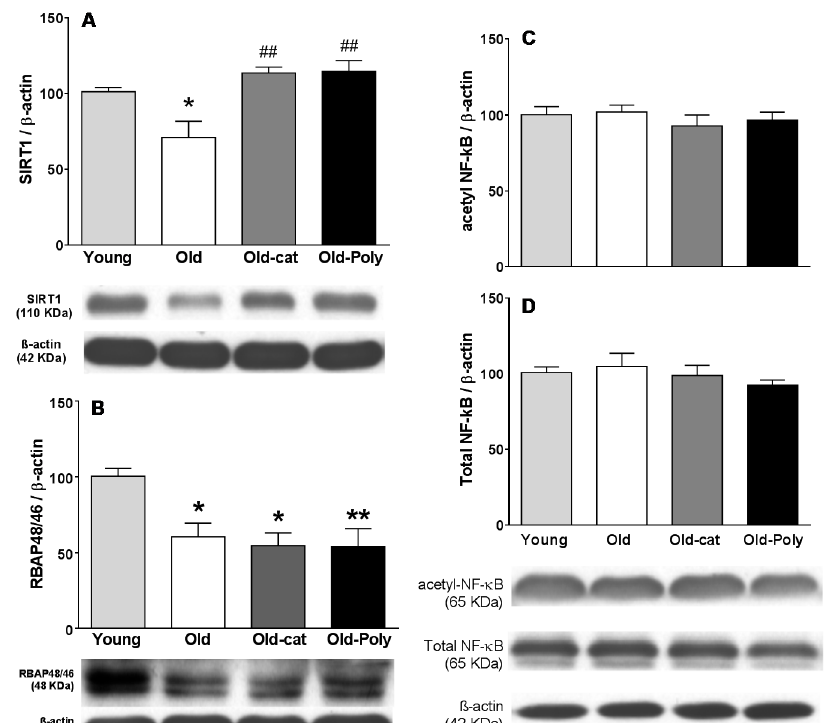
Figure 3. Effects of chronic polyphenon-60 and catechin treatments in hippocampal levels of SIRT1, RBAP46/48, and NF- κ B in old rats (18 months) and comparison with young rats (3 months). Western blot analysis of hippocampal levels of total SIRT1 ( A ), RBAP46/48 ( B ), and acetylated (K310) and total NF- κ B forms ( C and D ). Protein levels were normalized to β -actin content and each sample was analyzed in three different membranes. Bars represent mean ± SEM of protein levels expressed as percentage relative to the young group. Representative immunoblots are shown below graphs. Animals were treated with catechin ( n = 5; grey bars) or polyphenon-60 ( n = 6; black bars) (20 mg/kg, i.p., for 28 days; followed by 40 mg/kg, i.p., during an additional 7 days; both). Control animals received 1 mL/kg of corn oil for 40 days (i.p.; n = 6; white bars). Young animal group was used as reference to compare with old animals ( n = 6). One-way ANOVA followed by the Tukey post-hoc test was used for statistical analysis. * p < 0.05, ** p < 0.01 when compared with young animals. ## p < 0.01 when comparing treated groups with old control group.